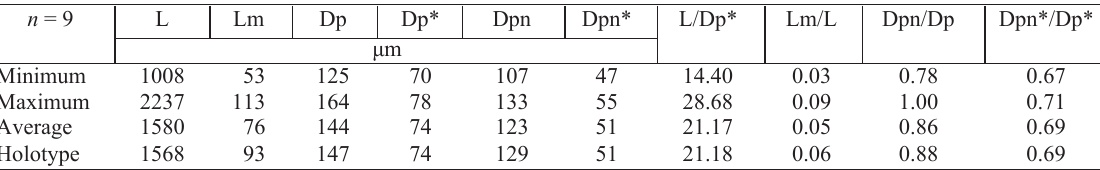
Table 3. Dimensions of nine flattened specimens of Eremochitina ? procera sp. nov. L = vesicle length, Lm = tubular membrane length, Dp = chamber diameter, Dpn = the narrowest neck diameter. Asterisk marks the application of the correction factors of 0.8 and 0.7 to the chamber and neck, Dp* = chamber diameter after correction, Dpn* = the narrowest neck diameter after correction. Correction factors of 0.8 and 0.7 for the chamber and neck are adopted according to Paris et al. (2015)